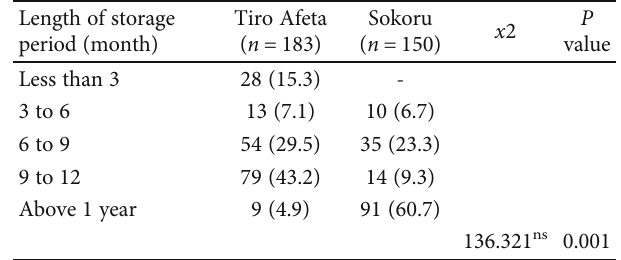
Table 1: Comparison of small-scale farmer ’ s maize storage duration in study districts.